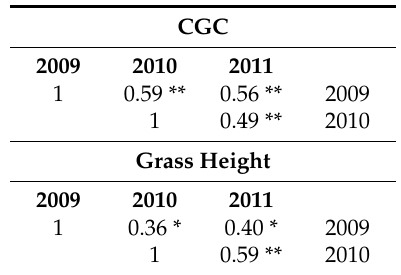
Table 5. Kappa index between the maps for Coverage of Grass Canopy (CGC) and grass height during the three years studied.